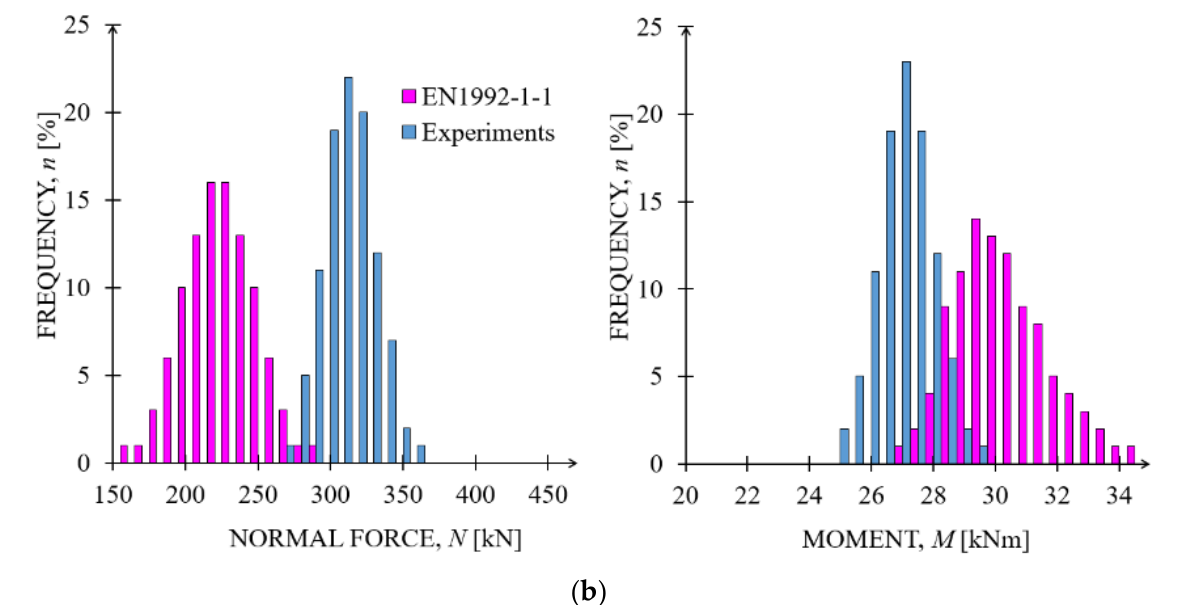
Figure 11. Statistical scattering failure loads obtained according to EN1992-1 nominal stiffness calculations (pink point set). ( a ) Nominal stiffness calculated and experimental N-M gradients vs. the Interaction Diagrams I-D according to EN1992-1 at the design, characteristic and mean levels, and, ( b ) histogram of the maximum calculated axial forces (pink) vs. those tested experimentally (blue) and histogram of the maximum calculated moments (pink) vs. those tested experimentally (blue).